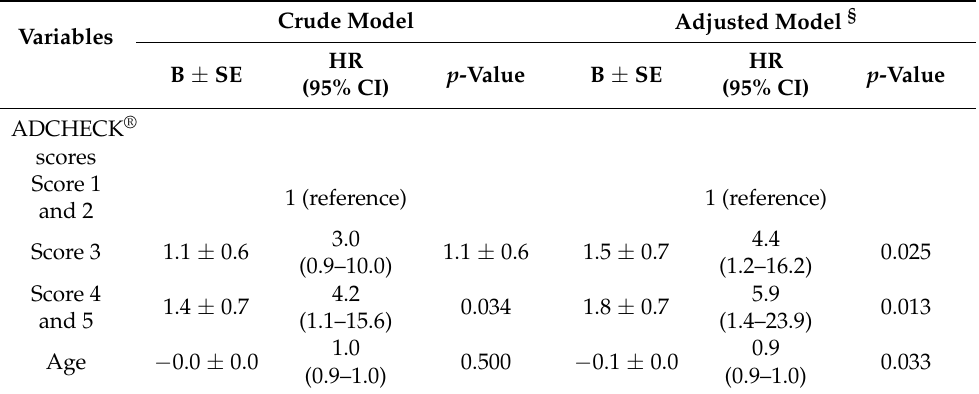
Table 3. Cox’s hazard analysis for onset of fever among groups based on ADCHECK ®